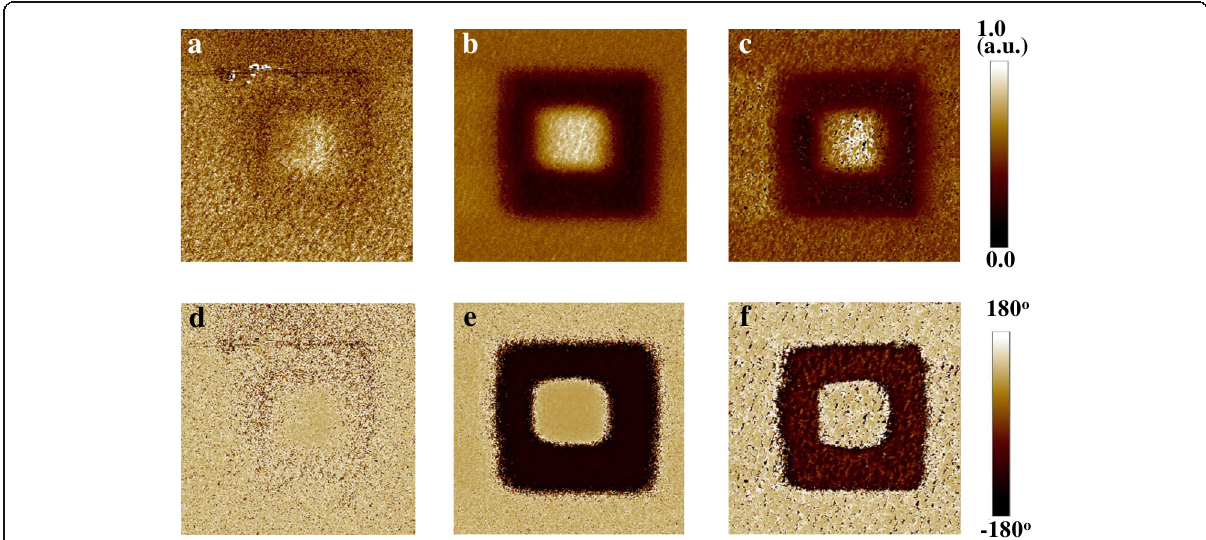
Fig. 5 a – c Amplitude (upper) and phase (lower) images of PFM measurement for 3.6, 6, and 10 nm NEI on TaN, respectively